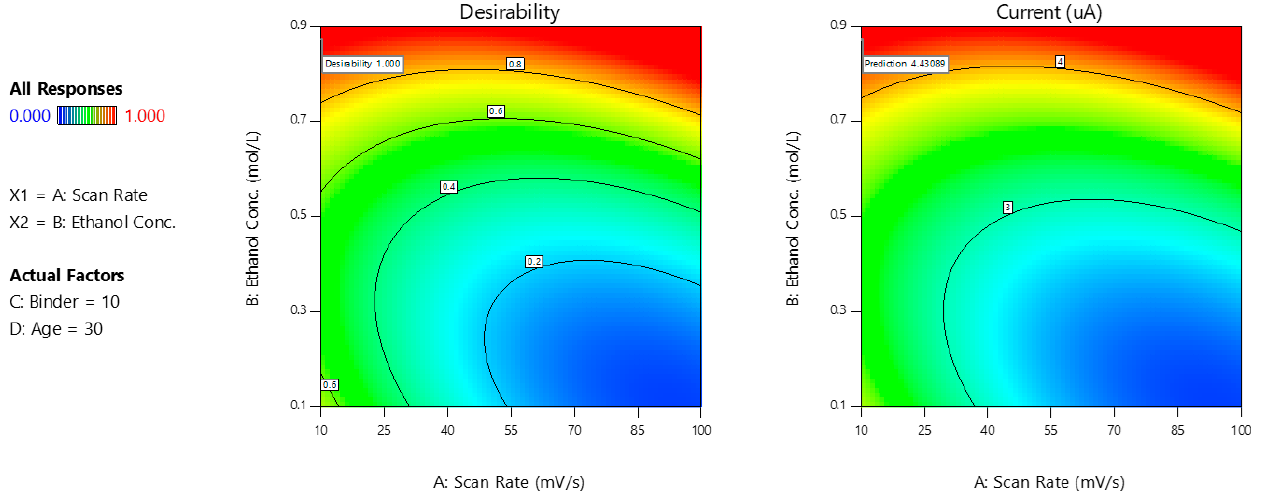
Figure 8. Contour plot: representation of the response plotted against combinations of factors.